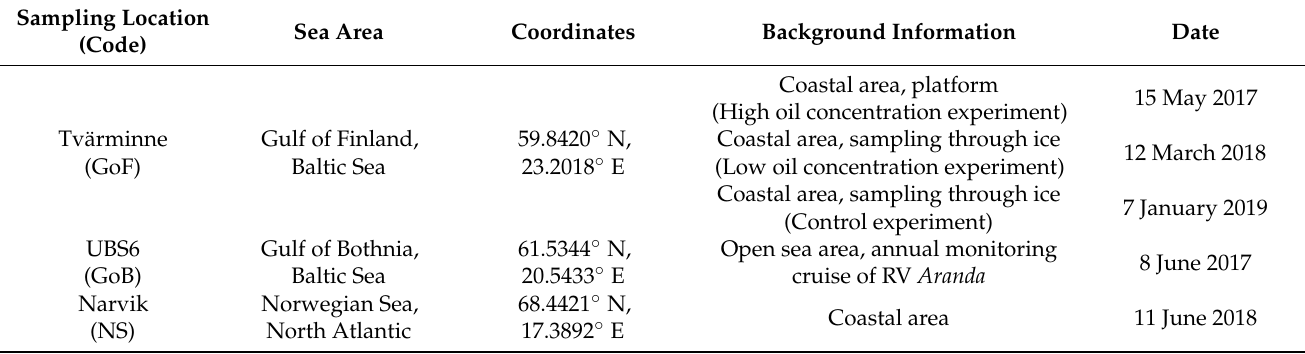
Table 1. Coordinates of the water sampling